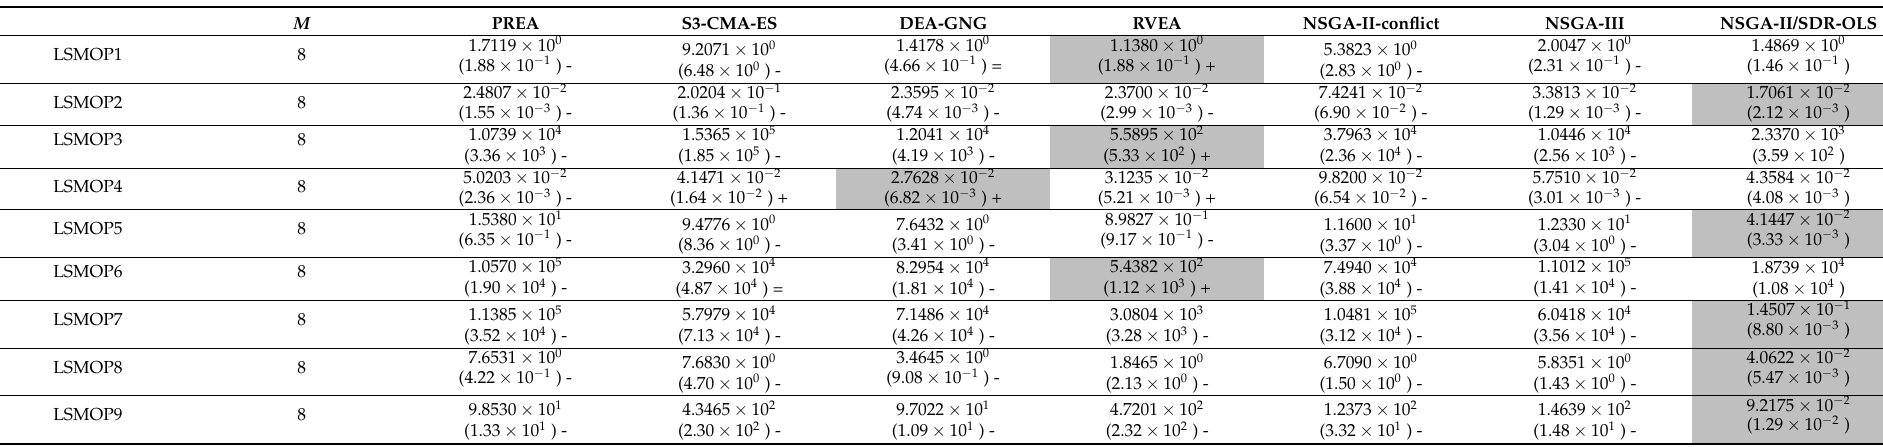
The gray background represents that this algorithm has the best performance on this problem. The number in the brackets represents the standard deviation, and the number out of the brackets represents the mean values. “+/-/=” means that the relevant algorithm performs better than/worse than/as well as the NSGA-II/SDR-OLS algorithm. Same below table. Table 11. GD values for 9 eight-objective benchmark